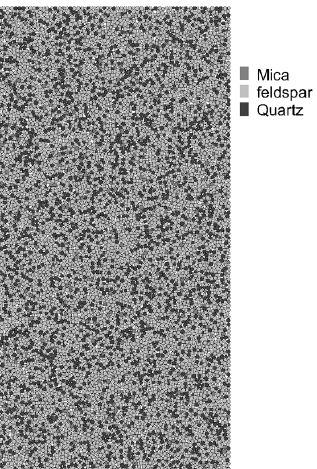
Figure 12. Particle flow model of Beishan